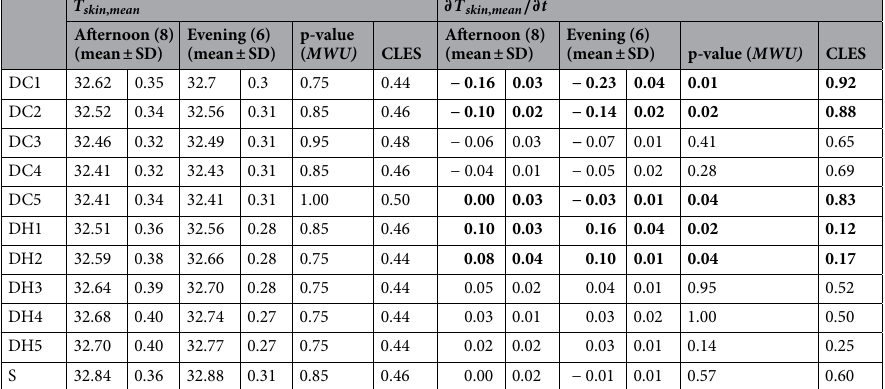
Table 3. Time-of-day differences in mean skin temperature and its rate of change over the course of the last two partial-body cooling and warming transients. Significant values are in bold.